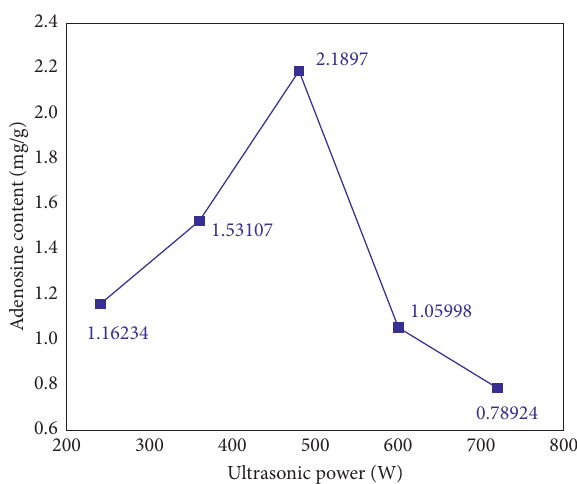
Figure 5: Effect of ultrasonic power on the adenosine